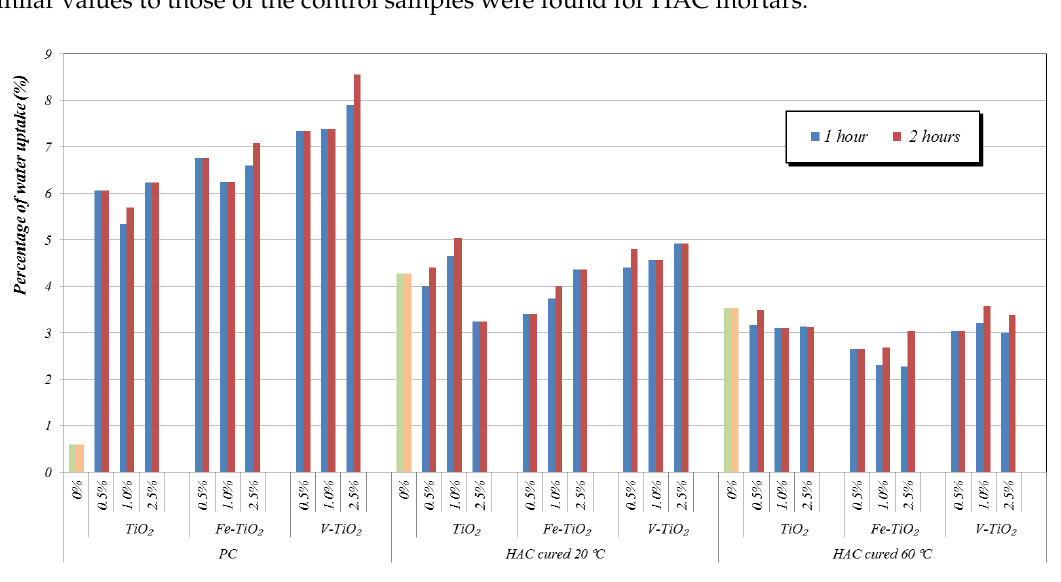
Figure 13. Water absorption of the mortars (after 28 curing days) in comparison with additive-free specimens (0%). Values measured after 1 and 2 h of water immersion.